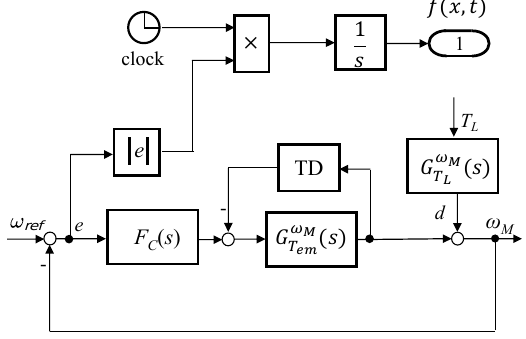
Figure 3. Block diagram to optimize controller